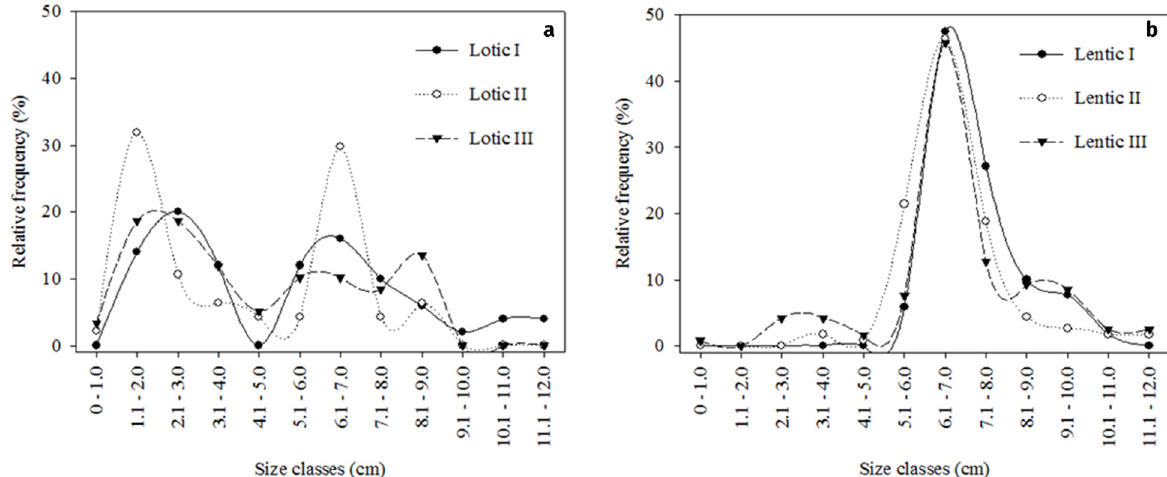
Figure 3. Histograms (size classes of standard length) of Astyanax lacustris individuals in the lotic (a) and lentic habitats (b) of Chavantes Reservoir, Middle Paranapanema